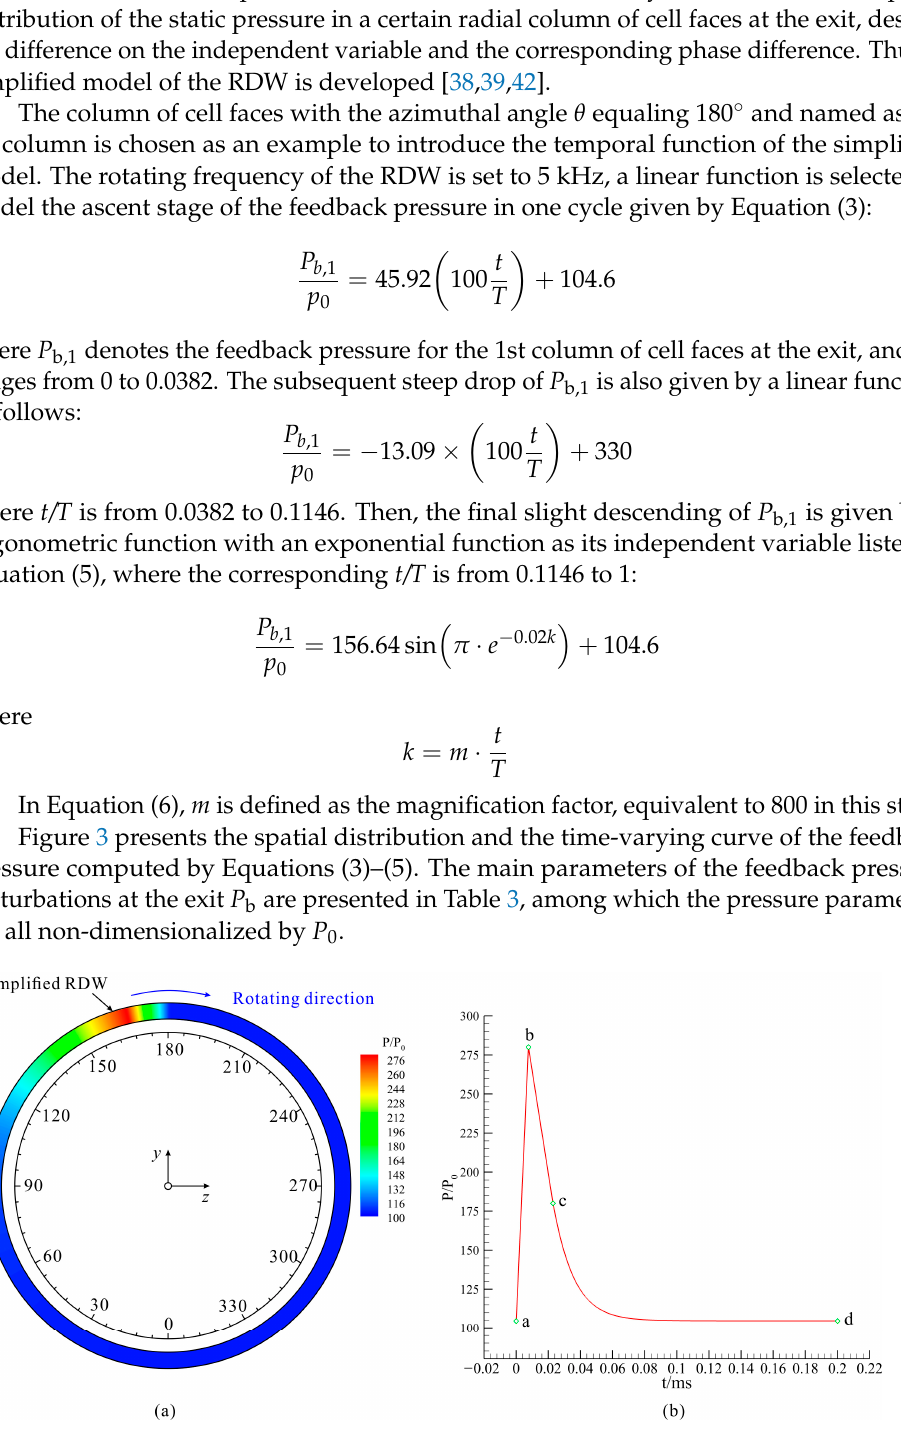
Figure 3. Spatial and temporal distribution of the feedback pressure. ( a ) Static pressure contour at the exit when t satisfies the equation floor ( t , T ) = 0. ( b ) The curve of the feedback pressure with time in a cycle, where P b in section a-b, b-c and c-d is calculated by Equations (3)–(5), successively. Table 3. Main parameters of P b .